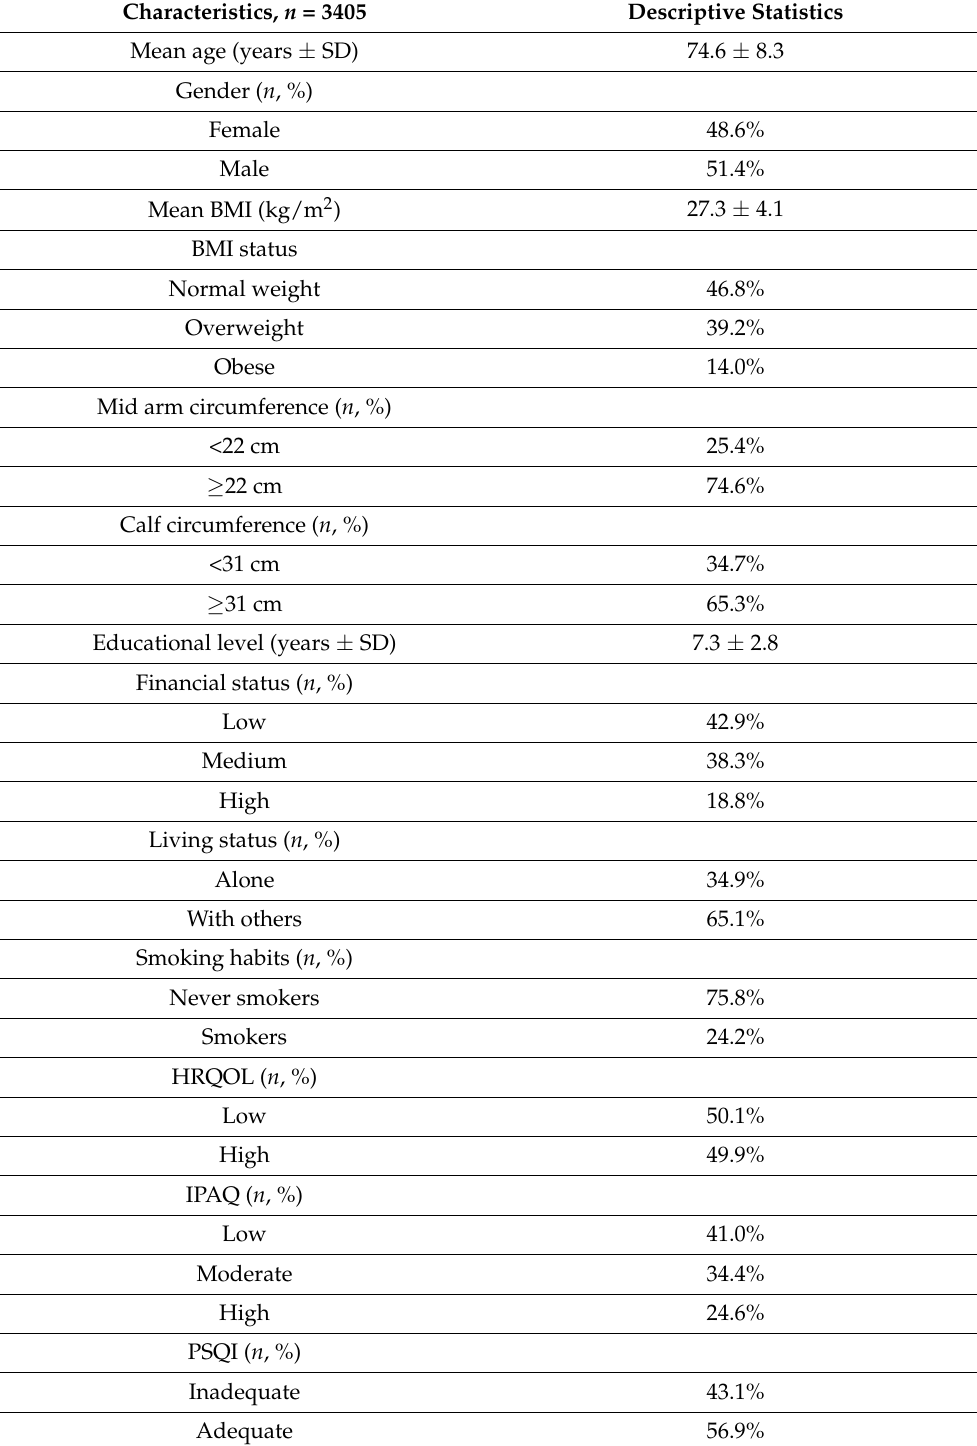
Table 1. Descriptive statistics of the study